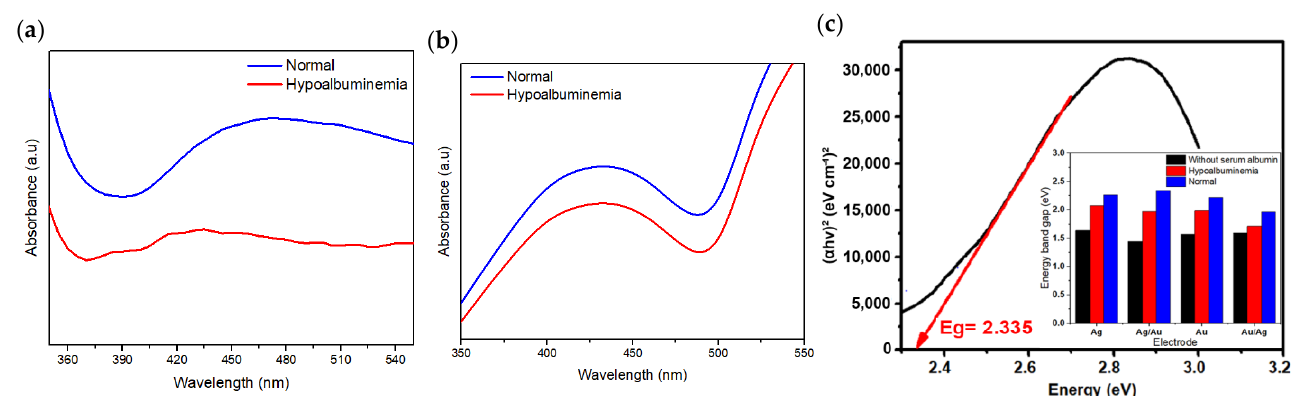
Figure 3. Results of the testing on the optical characteristics of the thin films using UV – Vis Spectroscopy: ( a ) experimental results; ( b ) simulation results; ( c ) the calculation of band gap energy values of Ag/Au thin film on serum albumin with normal concentration (inset: band gap energy value of Ag, Ag/Au, Au, and Au/Ag thin films using different concentration of serum albumin).